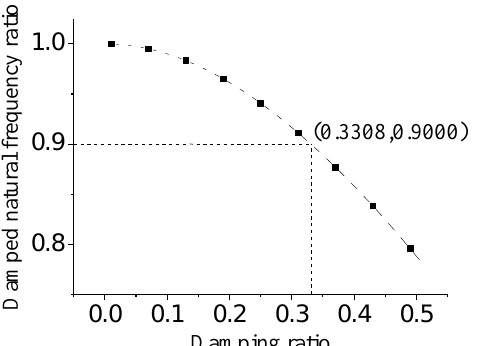
Figure 2. The change curve of damped natural frequency ratio.